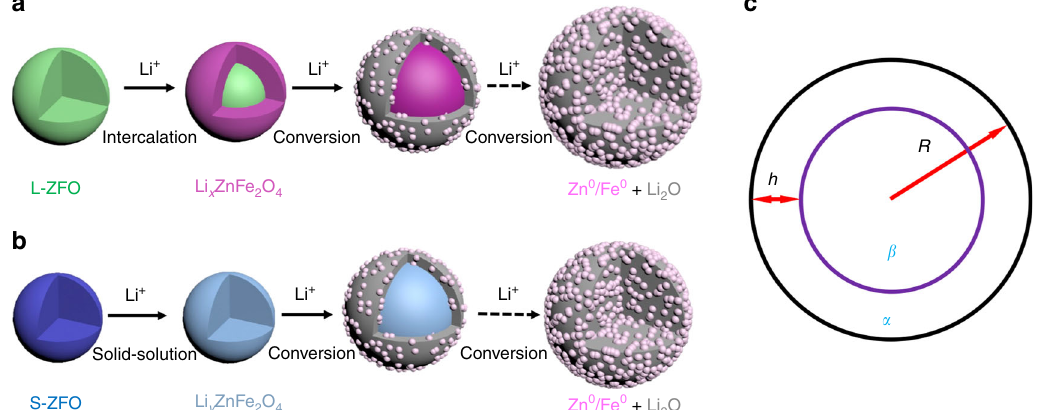
Fig. 5 Phase transformation pathway of L-ZFO and S-ZFO nanoparticles. Schematic 3D models illustrating the lithiation pathway of a L-ZFO and b S-ZFO. c Schematic diagram shows the coexistence of pre-existing phase ( β ) and newly formed phase ( α ) inside a particle undergoing a core-shell reaction mode, where R is the size of the particle and h is the thickness of α phase coated on the β